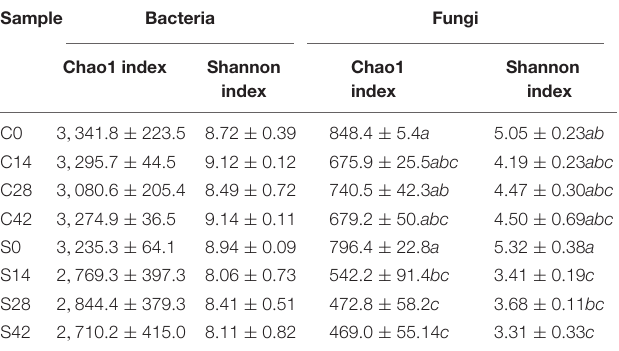
TABLE 2 | Analysis of alpha diversity estimators.